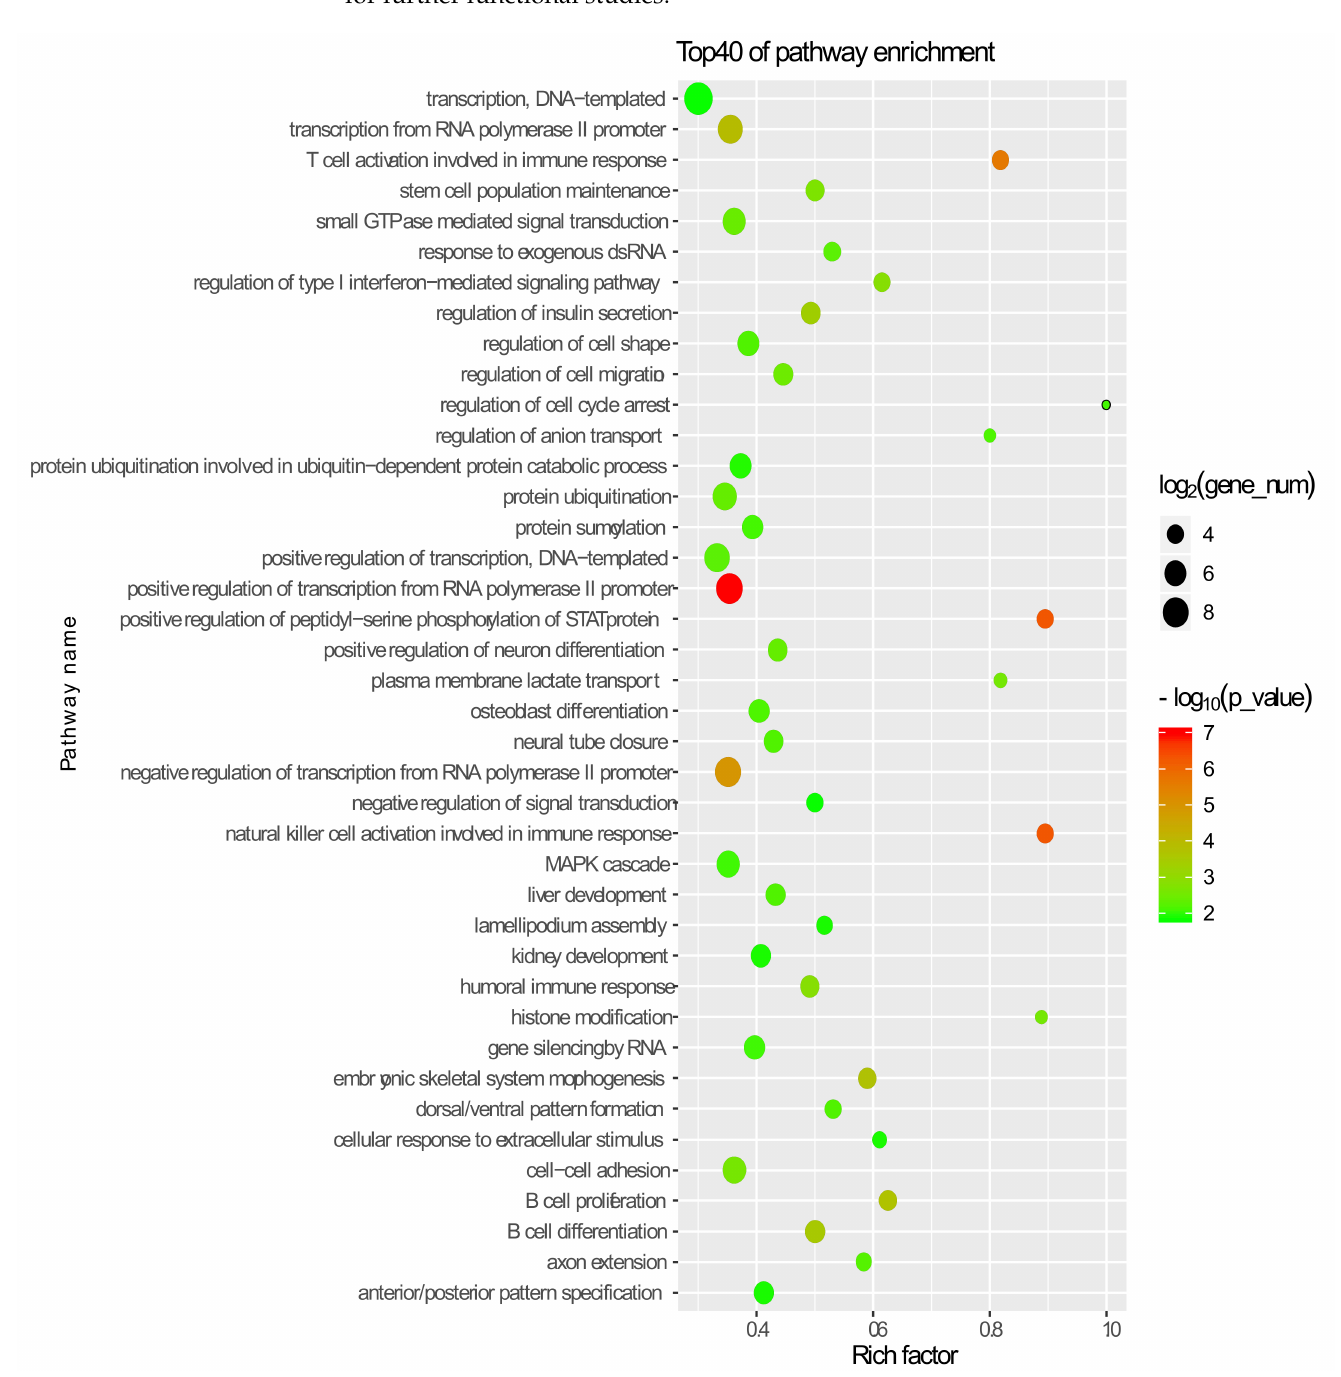
Figure 3. Top Go terms of its neighboring protein-coding